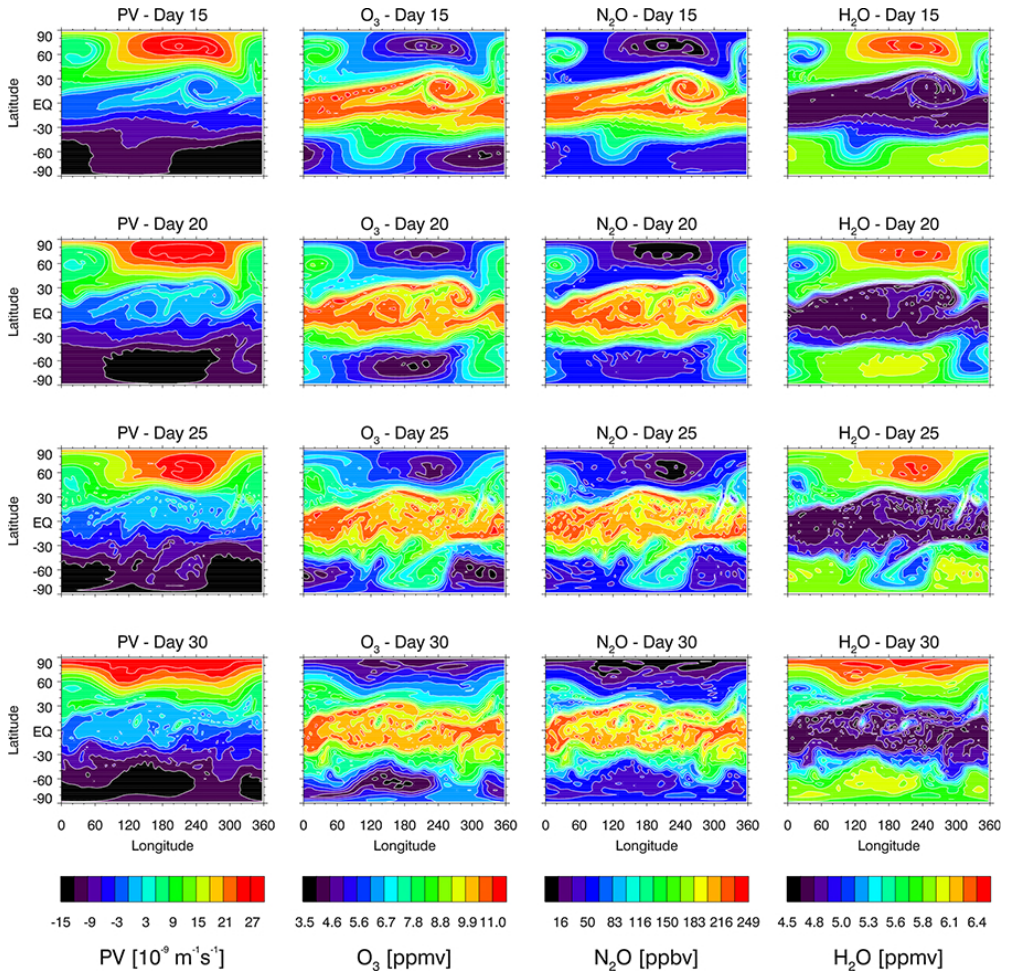
Fig. 2. Global maps of PV, O 3 , N 2 O, and H 2 O (columns 1, 2, 3, and 4, respectively) for days 15, 20, 25, and 30 (rows 1, 2, 3, and 4, respectively) during the nature run. For all maps red (blue) contours indicate high (low) values. Units are 10 − 9 m − 1 s − 1 for PV and parts per million by volume (ppmv) for O 3 and H 2 O and parts per billion by volume (ppbv) for N 2